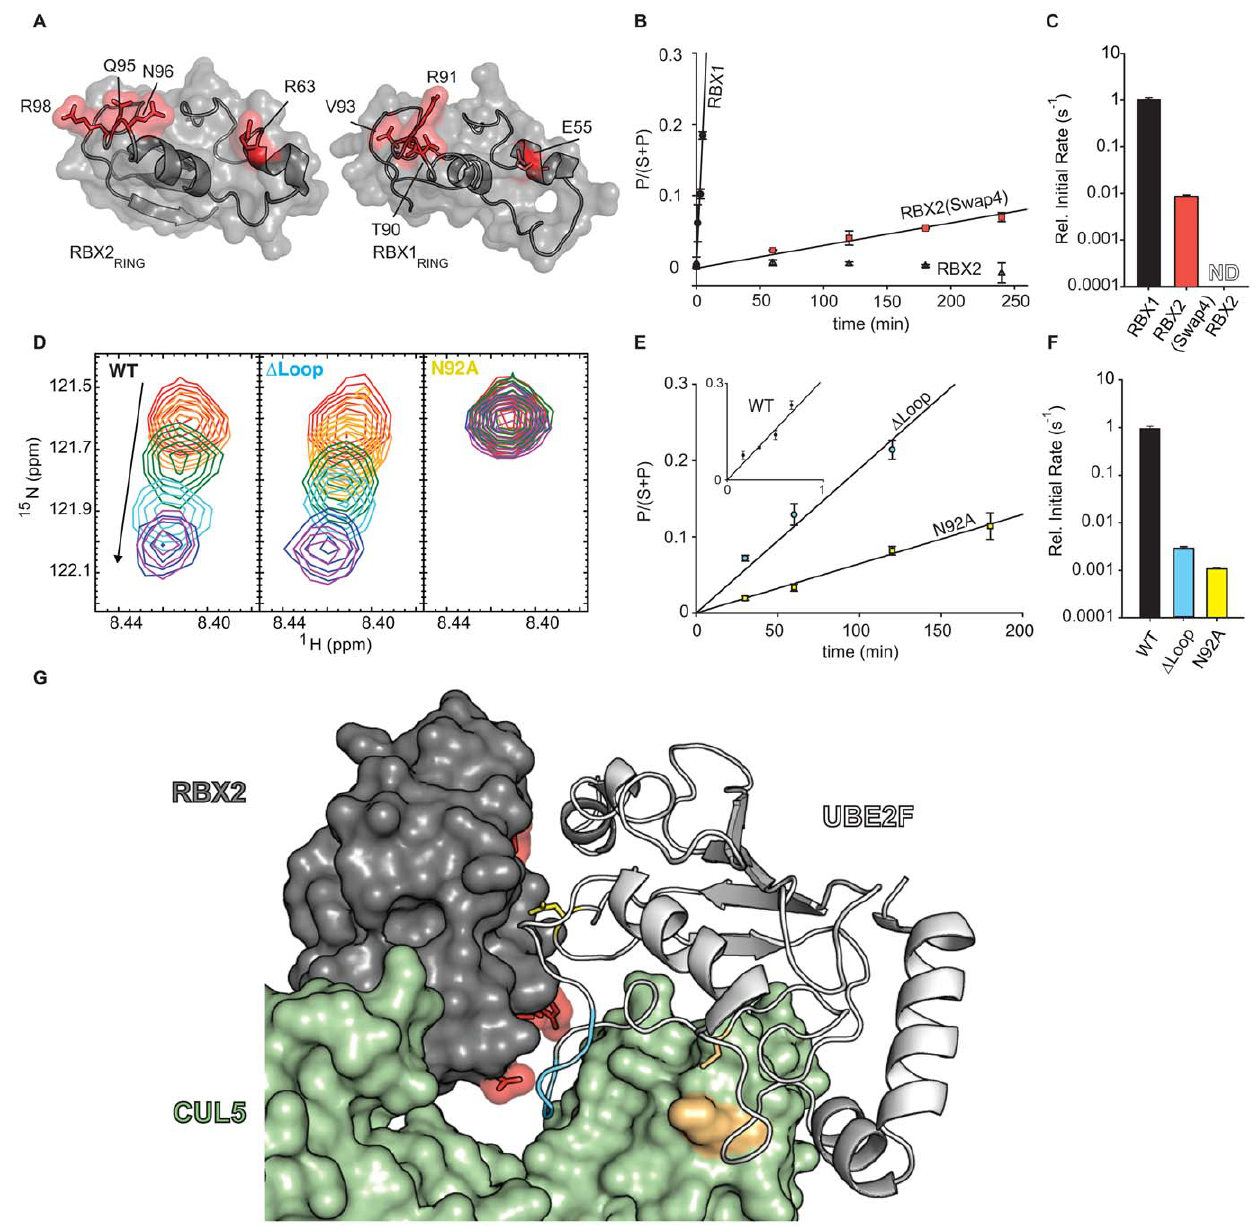
Figure 5. Structural basis for discrimination between NEDD8 pathways. A, Surface representations of RBX1 RING and RBX2 RING with divergent surface residues (Swap4) targeted for substitution analysis. Coordinates for RBX1, RBX2 were from PDB files 2EDI and 3DQV, respectively. B, Time courses of NEDD8 transfer from UBE2M to indicated CUL5/RBX complexes and C, relative initial rates for NEDD8ylation normalized to CUL5/RBX1. Error bars indicate standard deviation between at least two experiments. D, Excerpts from 15 N-HSQC spectra of RBX2 titrated with increasing concentrations of unlabelled wild-type or mutant UBE2F. E, Time courses for NEDD8 transfer from wild-type and UBE2F mutants to CUL5/RBX2. Error bars indicate standard deviation between at least two experiments. F, Relative initial rates for NEDD8ylation of CUL5/RBX2 normalized by wild-type UBE2F. Error bars indicate standard deviation between at least two experiments. G, Model of CUL5/RBX2/UBE2F complex based on CUL1/RBX1 crystal structure (3RTR) and cIAP2/UBE2D2 crystal structure (3EB6) [33,60]. UBE2F, RBX2 and CUL5 are shown in white, grey, and green respectively. The catalytic cysteine of UBE2F and the NEDD8 acceptor lysine of CUL5 (K724) are shown in orange; the unique loop insertion of UBE2F, blue; Asn92 of UBE2F, yellow sticks; and residues of RBX2 targeted for Swap4 mutation, red. Details of modeling can be found in the Experimental